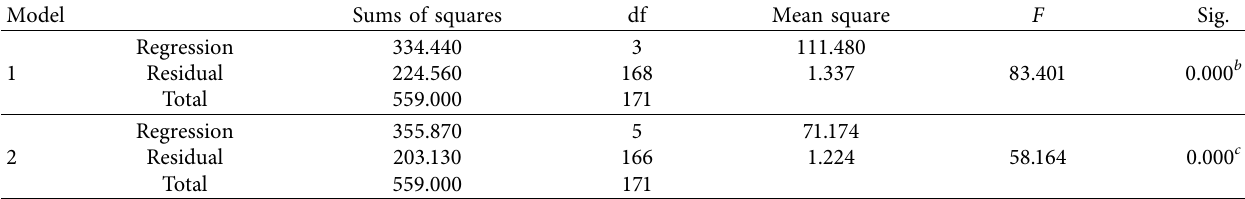
Table 8: ANOVA for leadership skills, stakeholder management, project scope, and execution of fibre optic infrastructure. Model